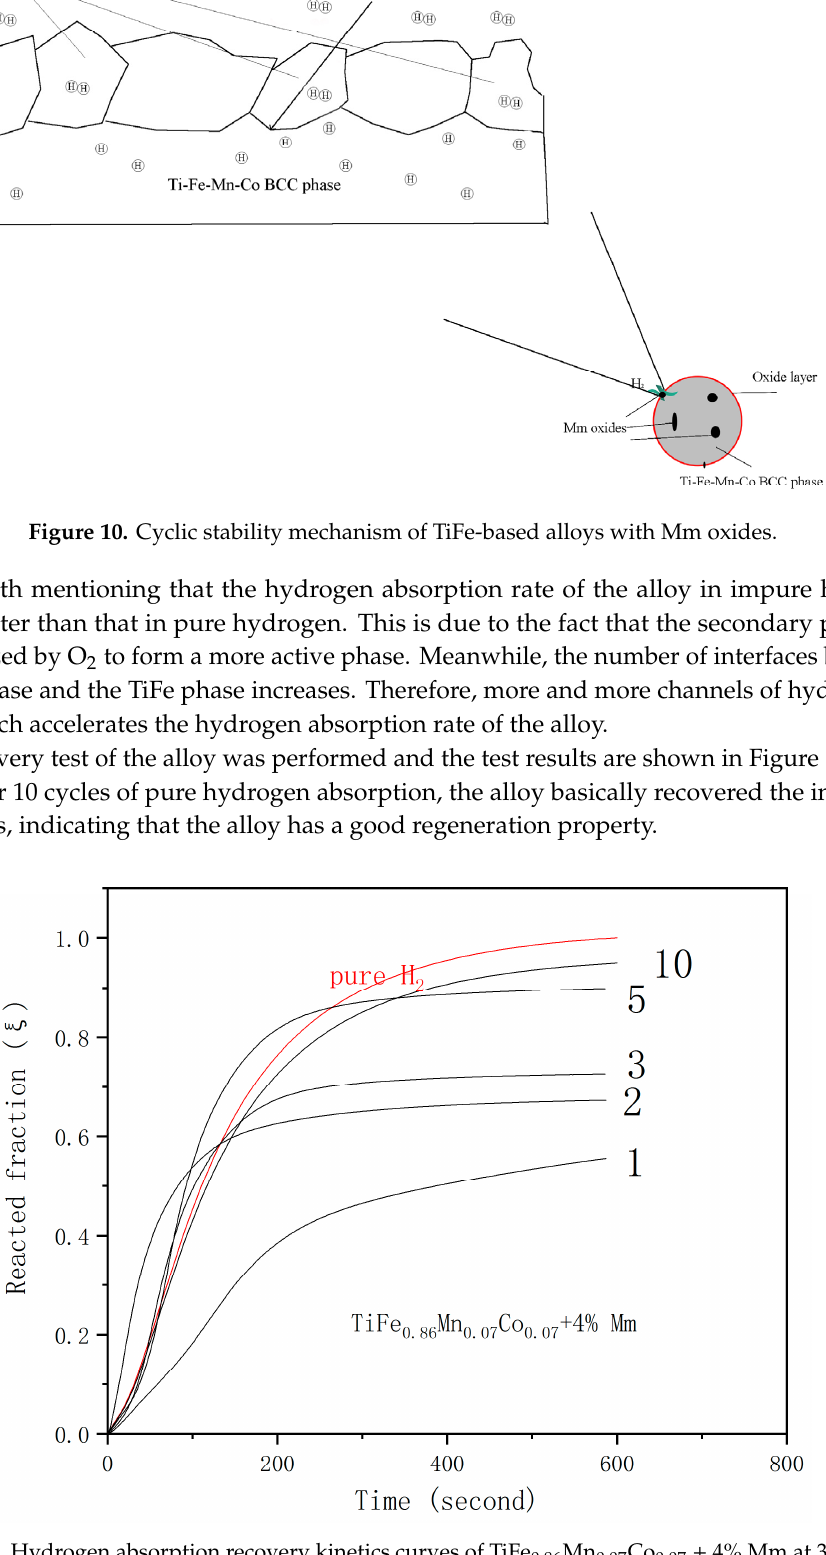
Figure 11. Hydrogen absorption recovery kinetics curves of TiFe 0.86 Mn 0.07 Co 0.07 + 4% Mm at 3 MPa of pure H 2 at 298